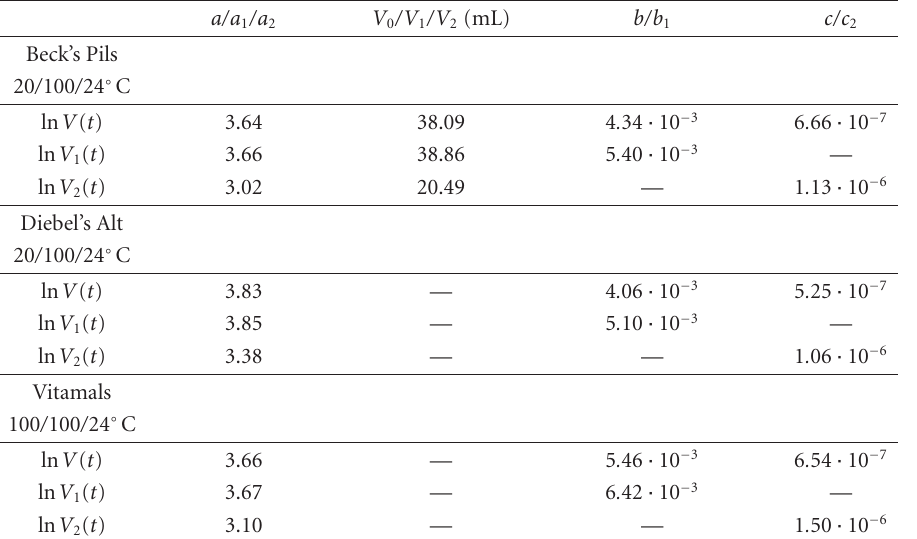
Table 3.3. Comparison of beer foam decay for di ff erent kinds of beer under the same constraints of the 20 / 100 / 24 ◦ C